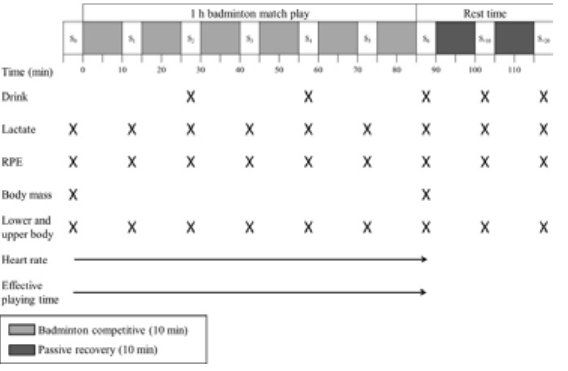
Figure 1. Experimental